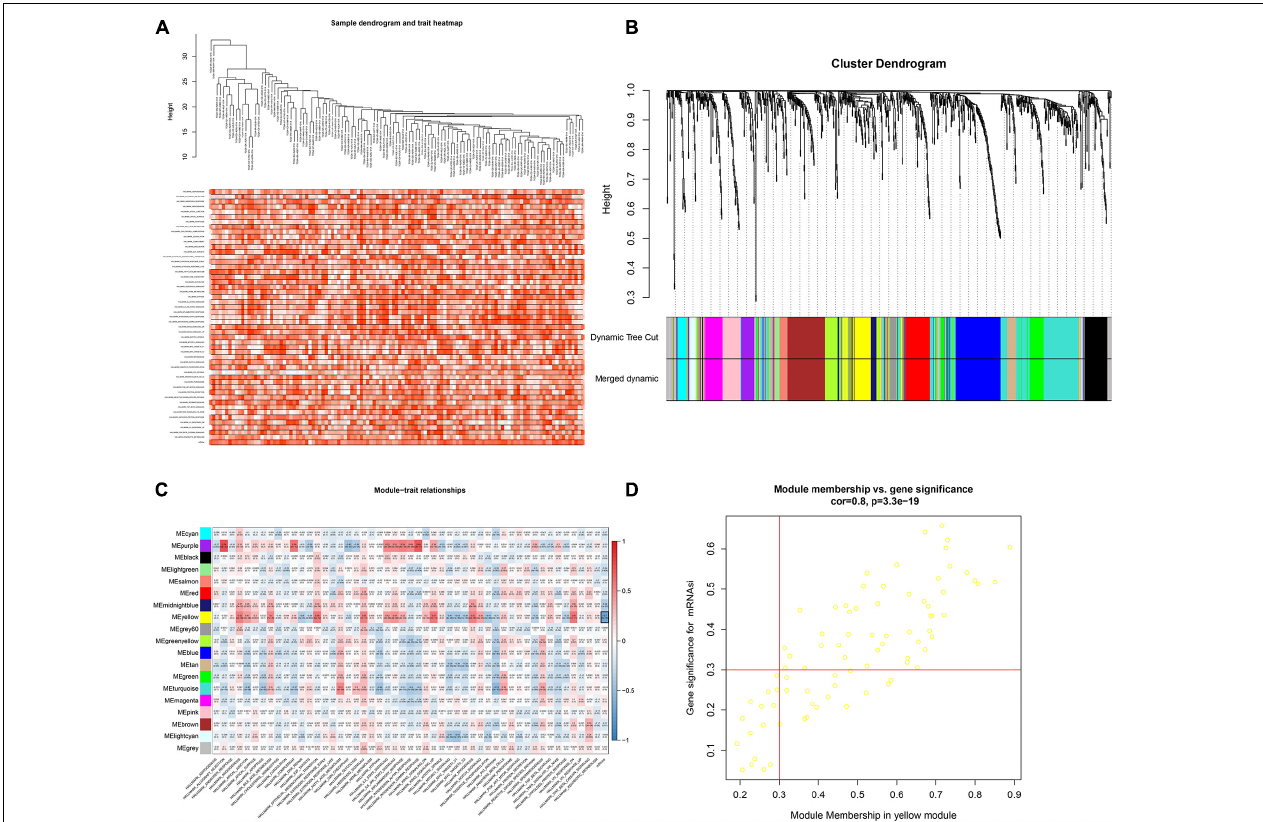
FIGURE 3 | Clustering based on the transcriptional level of 50 hallmark gene sets in chordoma samples (A) . Hierarchical clustering tree developed by the weighted correlation coefficients. Each branch represents a co-expression module in different colors (B) . Heatmap showing the correlation between modules and hallmark gene sets. The framed yellow module was the key module which was most relevant to mRNAsi. Gene Significance (GS) and its corresponding p value were computed and shown in the heatmap (C) . Scatter diagram showing the correlation between gene significance for hallmarks of cancer and Module Membership in yellow module (D)